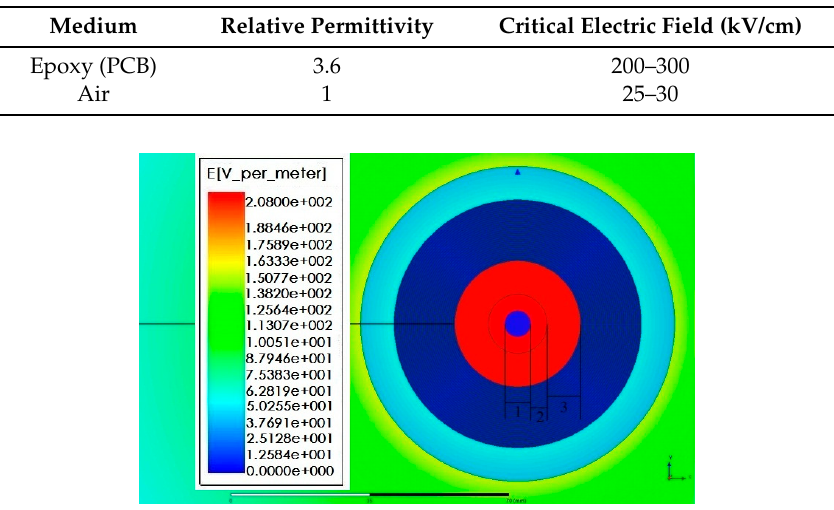
Figure 12. Insulation intensity of sensor electrode and simulation calculation.